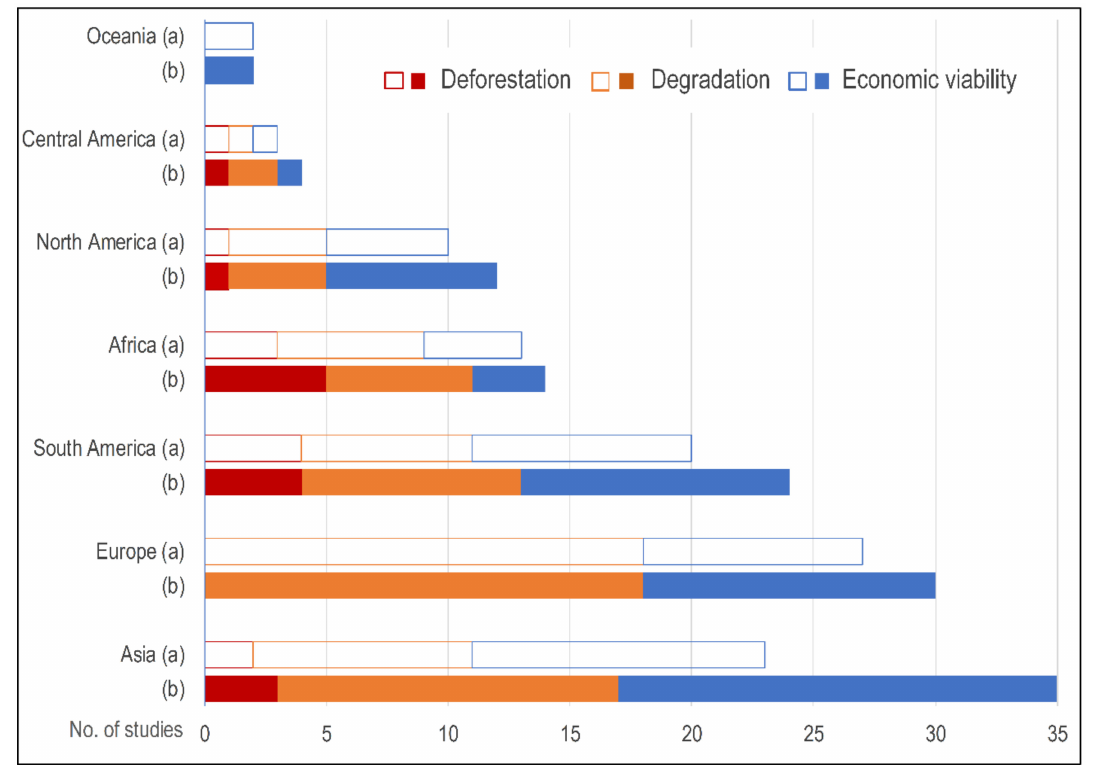
Figure 1. Regional distribution of (a) publications and (b) case studies per target variable (deforesta- tion, forest degradation, economic